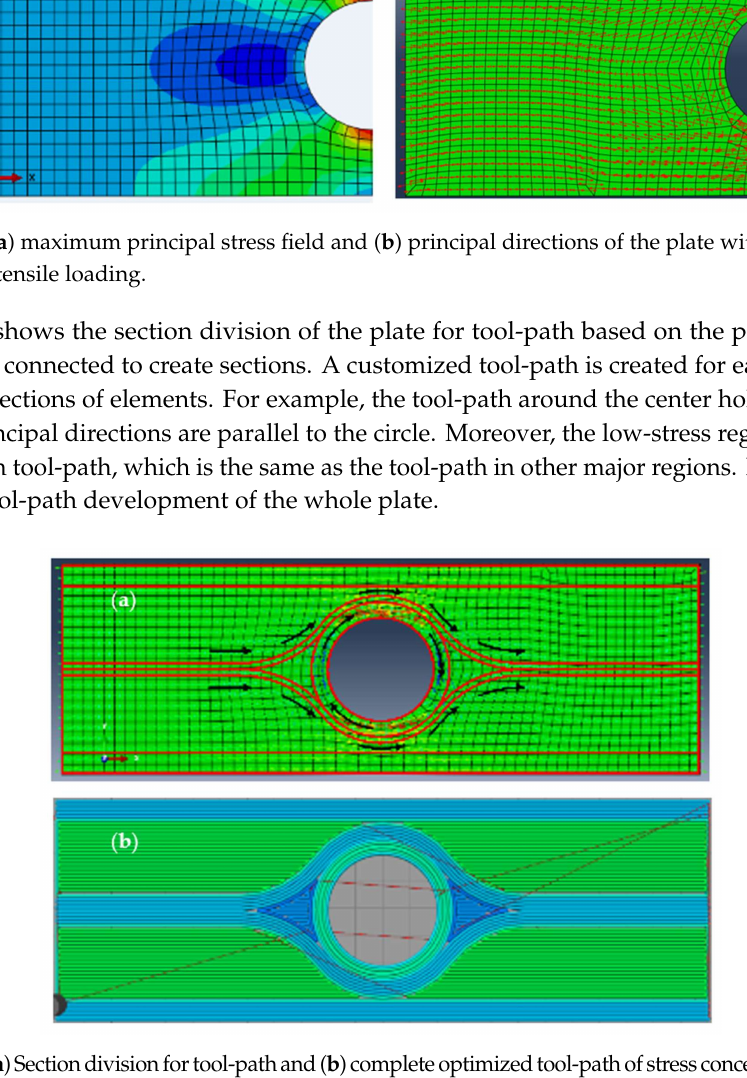
Figure 19. ( a )Sectiondivisionfortool-pathand( b